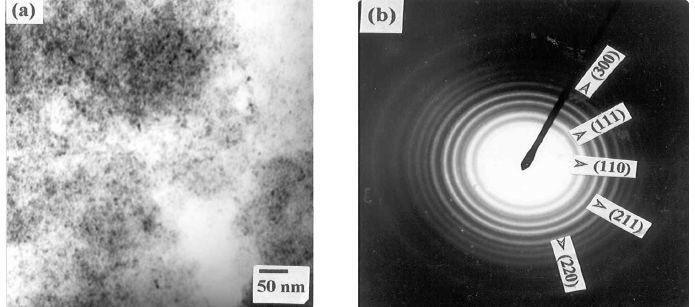
obtained after heat treatment at 750 o C and 3